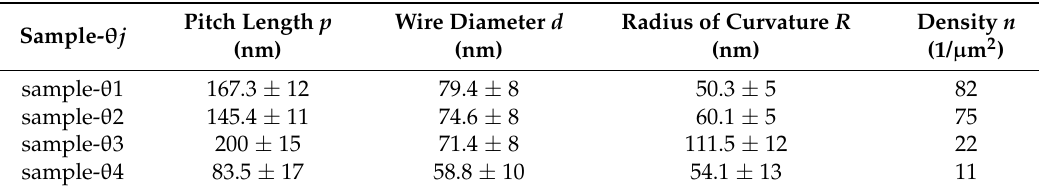
Table 2. Pitch length ( p ), wire diameter ( d ), radius of curvature ( R ), and density ( n ) of sample- θ j , j = 1, 2, 3, 4.